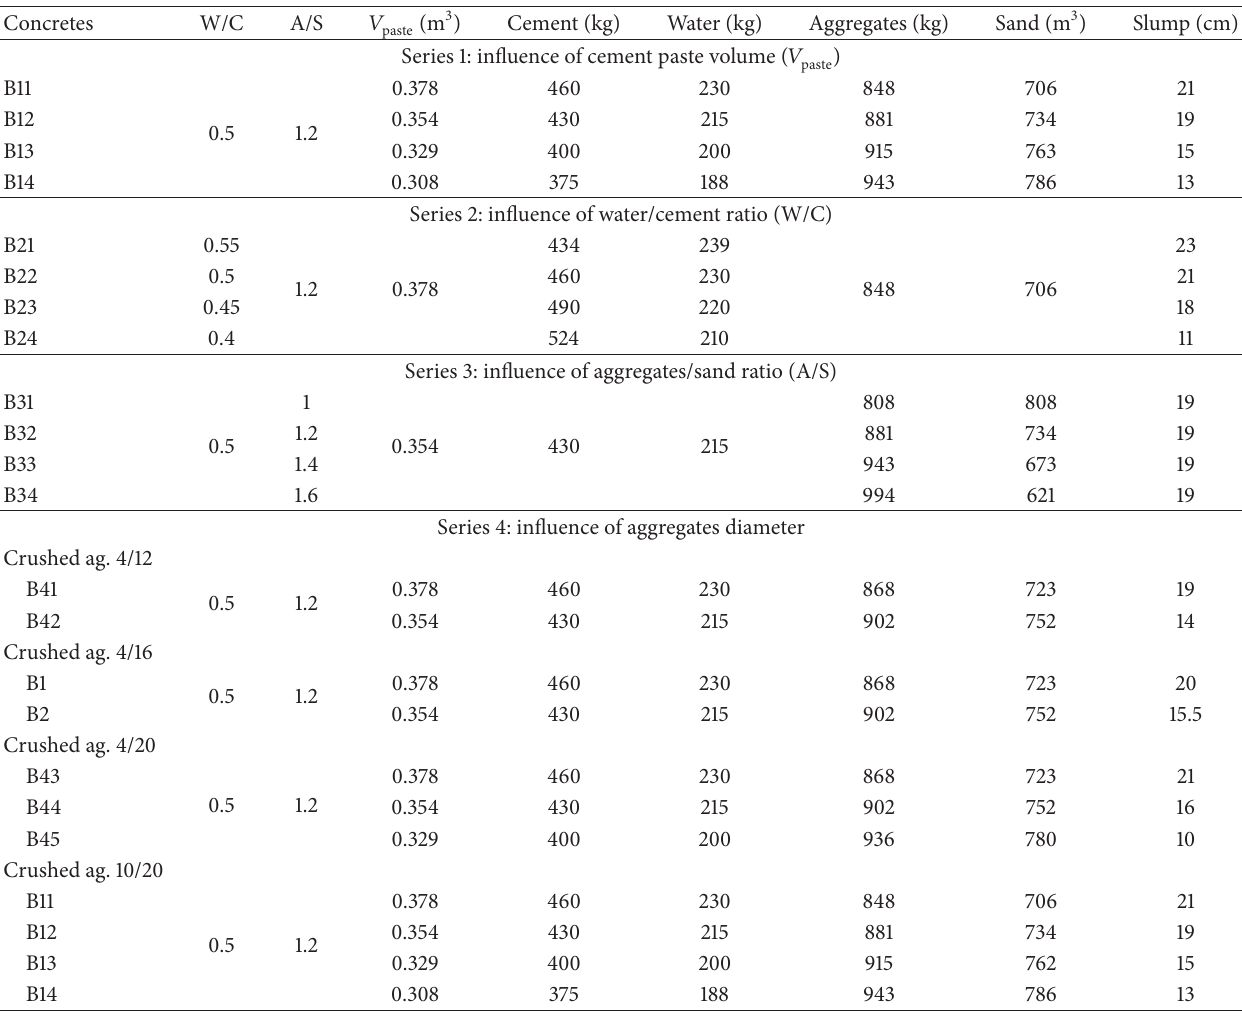
Figure 6: Example of tribometrical test result: (a) raw test result and (b) schematic view of concrete shear stress, shearing rate relation. Table 1: 1st program: tested concretes’ composition without